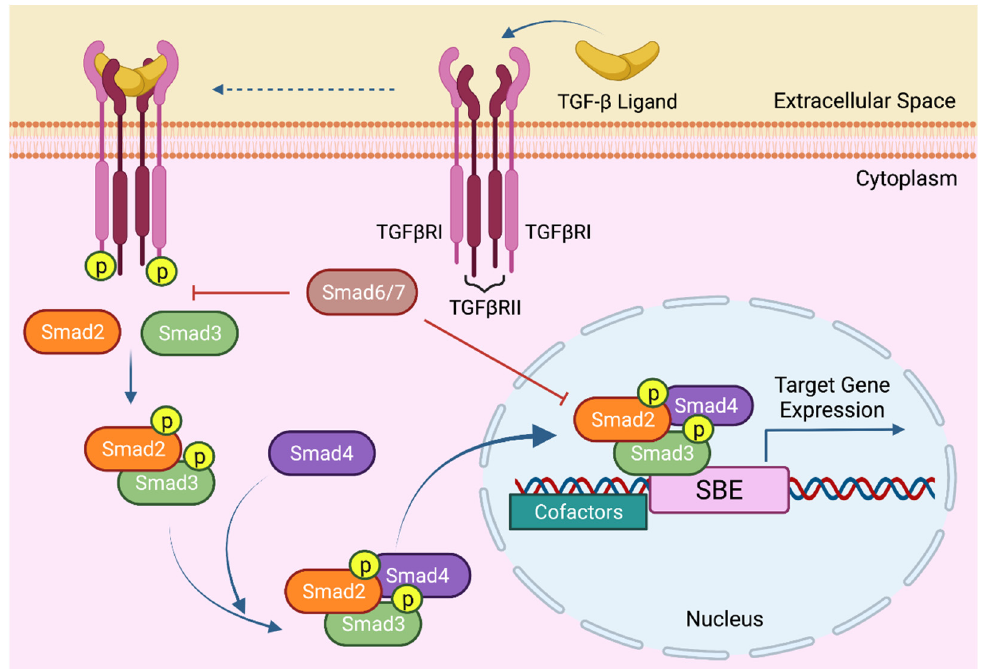
Figure 1. Canonical TGF- β Signaling. The TGF- β signaling pathway initiates with the binding of the TGF- β ligand to TGF β RII. Activated TGF β RII forms a complex with and phosphorylates TGF β RI. Upon phosphorylation by TGF β RI, R-Smads, Smad2, and Smad3, form a transcriptional complex with the co-Smad, Smad4. This complex then translocates into the nucleus, associates with DNA by cooperating with various cofactors, and regulates target gene expression. Smad6 and Smad7, the I-Smads, function as negative regulators of TGF- β /Smad signaling.